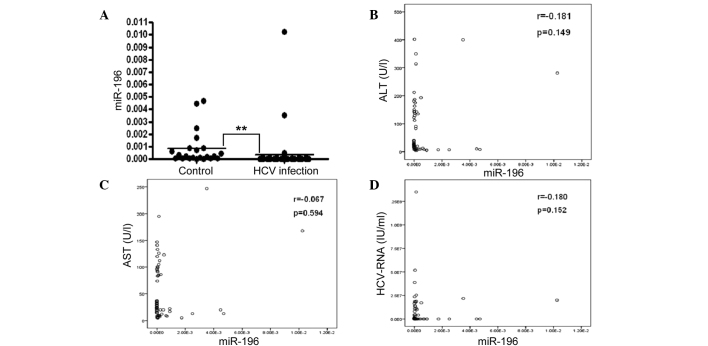
Reduced serum miR-196a levels in patients with CHC. (A) Comparison of miR-196a concentrations between CHC and healthy controls. Serum miR-196a concentrations in correlation with (B) ALT, (C) AST and (D) HCV-RNA. **P<0.001. miR, microRNA; CHC, chronic hepatitis C; ALT, alanine aminotransferase; AST, aspartate aminotransferase; HCV, hepatitis C virus.